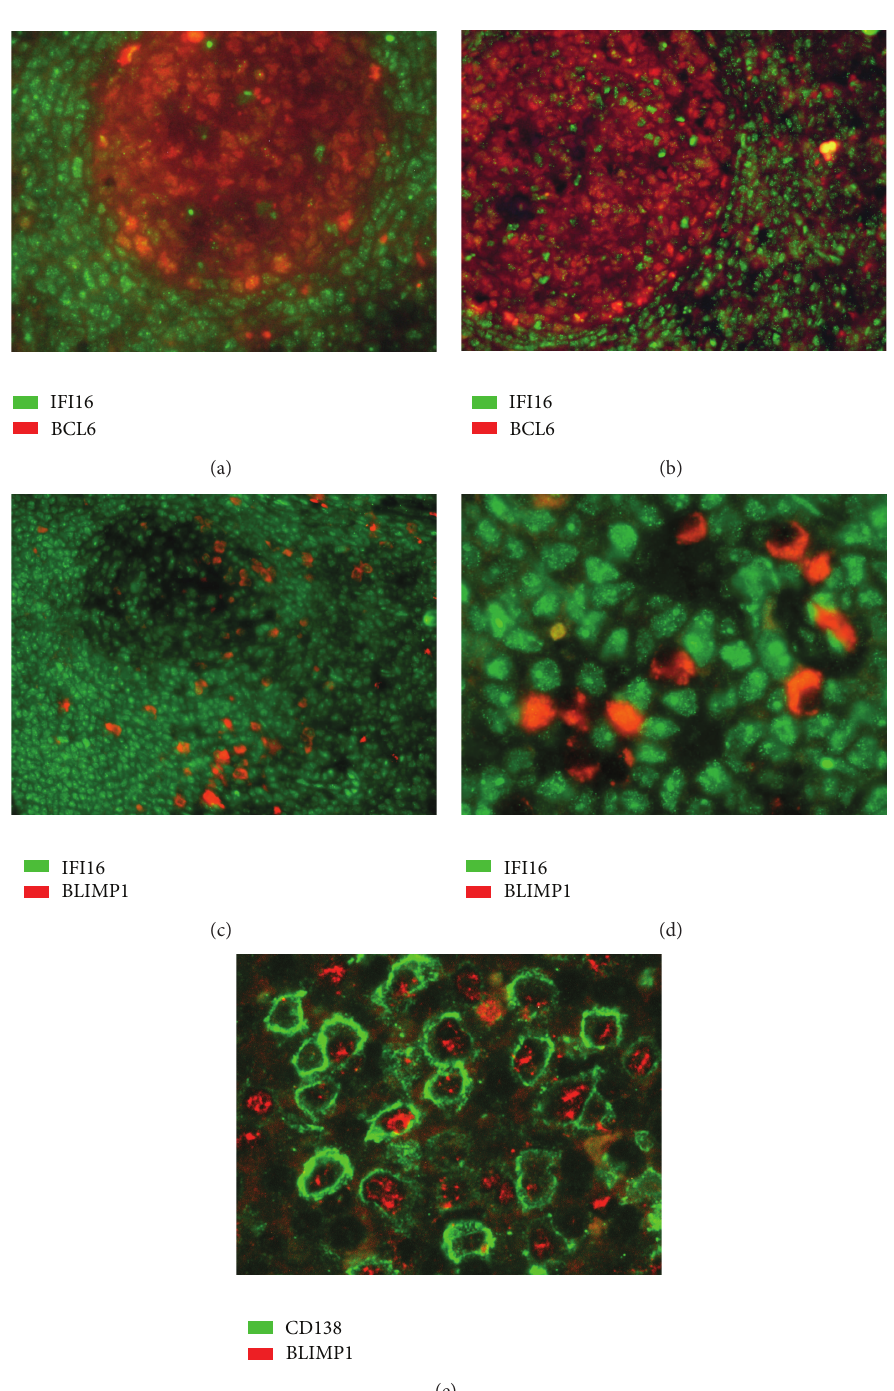
Figure 6: Double-staining immunofluorescence analysis of IFI16/BCL-6 and IFI16/BLIMP1 protein expression levels. Double-staining immunofluorescence analysis demonstrated the inverse relationship between IFI16 (green) and either BCL6 (red; (a-b) magnification 200x and 100x, resp.), or BLIMP1 (red; (c-d), magnification 100x and 400x, resp.). The latter, in particular, showed a mutually exclusive expression patterns with IFI16. Specifically, plasma cells in panel (d) were BLIMP1+/IFI16 − , while the surrounding lymphocytes were BLIMP1 − /IFI16+. In (e) (magnification 400x) double-staining immunofluorescence analysis showed the coexpression of BLIMP1 (red) and plasma cell marker CD138 (green). These micrographs were obtained using an Olympus BX61 microscope equipped with an Olympus DP-70 digital camera; image acquisition, evaluation, and color balance were performed using Cell ∧ F